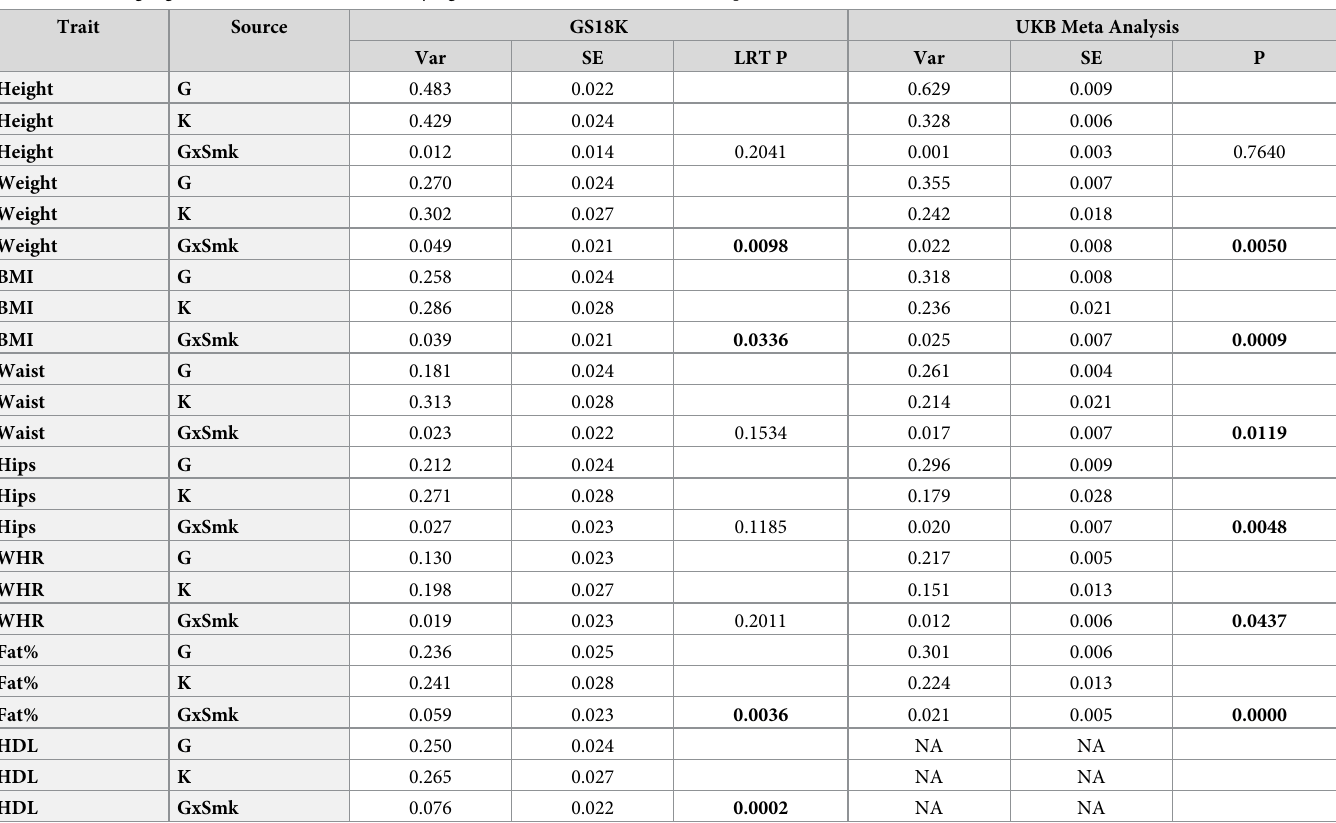
Table 1. Summary of interaction results for all cohorts. Results of GKGxSmk model for all traits in GS18K and meta-analysis of the recruitment centre-based sub- cohorts in UK Biobank. The table shows, for each trait, the proportion of the phenotypic variance explained (Var), its standard error (SE), the log-likelihood ratio test P value (LRT P, only for the interaction), the meta-analysis P value (P), for each of the components in the model: Genetic (G), Kinship (K) and Genome-by-Smoking interac- tion (GxSmk). Highlighted P values indicate nominally significant results for the GxSmk